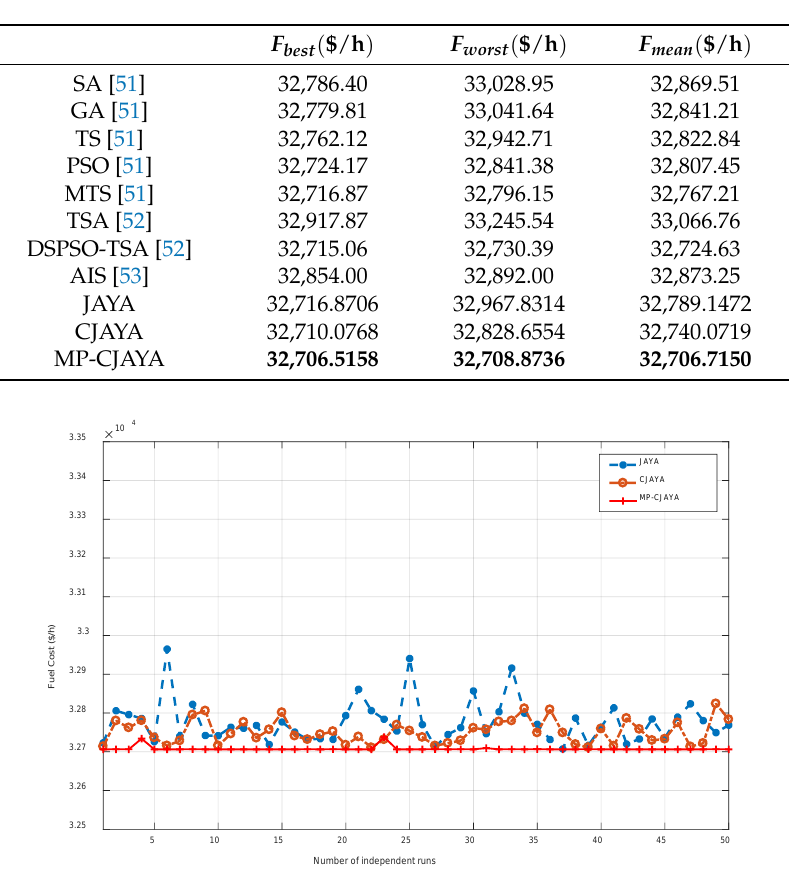
P = 2630 MW). P = 2630 MW). D D